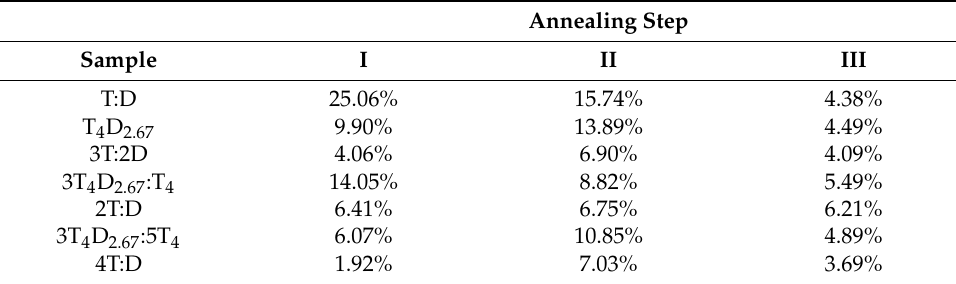
Figure 10. TG analysis of precursors. Table 1. Mass loss in each annealing step.